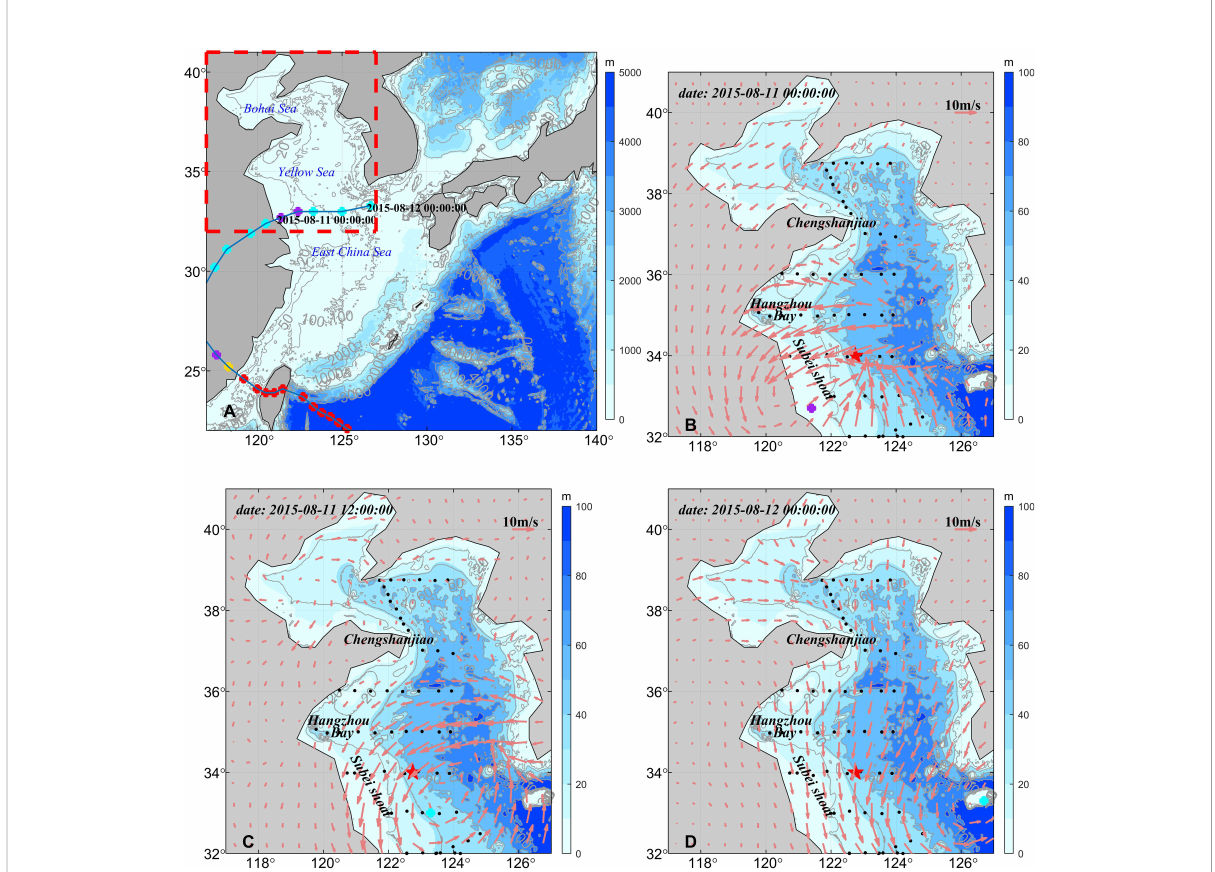
FIGURE 1 Model domain with topography (A) and the evolution of the wind fi eld in the study area (B – D) . The red dashed box represents the location of the Yellow Sea and Bohai Sea. The blue line represents the trajectory of the cyclone and the colored circle dots represent the intensity of the cyclone. The red, yellow, blue and purple circle dots represent typhoon, severe tropical storm, tropical storm and tropical depression, respectively. Colored shading and grey solid lines denote bathymetry. The black dots represent the locations of conductivity-temperature-depth pro fi ler stations from the cruise surveys in August 2015. The red star represents the mooring station and arrows represent wind